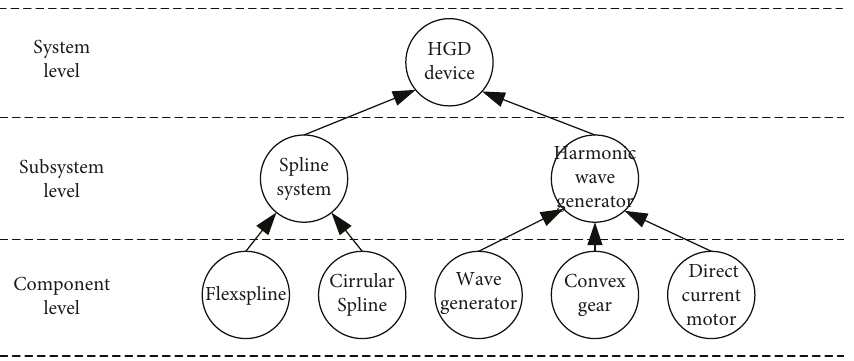
Figure 2: Physical model of the HGD product.